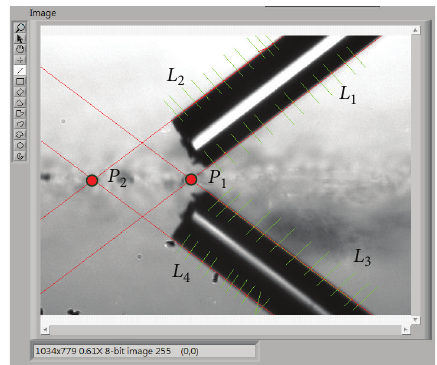
Figure 3: Edges of optical fiber and reflection image.